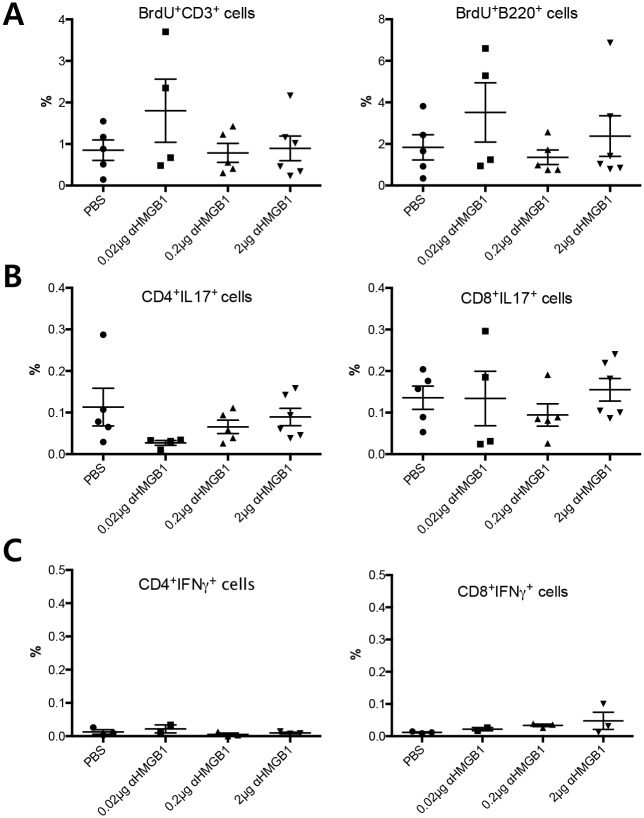
Changes in percentage of adaptive immune cells in draining lymph nodes of NOD.B10.H2b mice after anti-HMGB1 treatment.(A) BrdU staining showing no significant proliferative changes in CD3+ T cells or B220+ B cells. (B) Percentage of Th17 (CD3+CD4+IL-17hi) cells and Tc17 (CD3+CD8+IL-17hi) cells were not altered after treatment. (C) IFNγ-secreting T cells (CD3+CD4+IFNγhi or CD3+CD8+IFNγhi) were not affected by treatment. Data are presented as mean ± standard error. (Th17, T helper cells secreting IL-17; Tc17, cytotoxic T cells secreting IL-17).